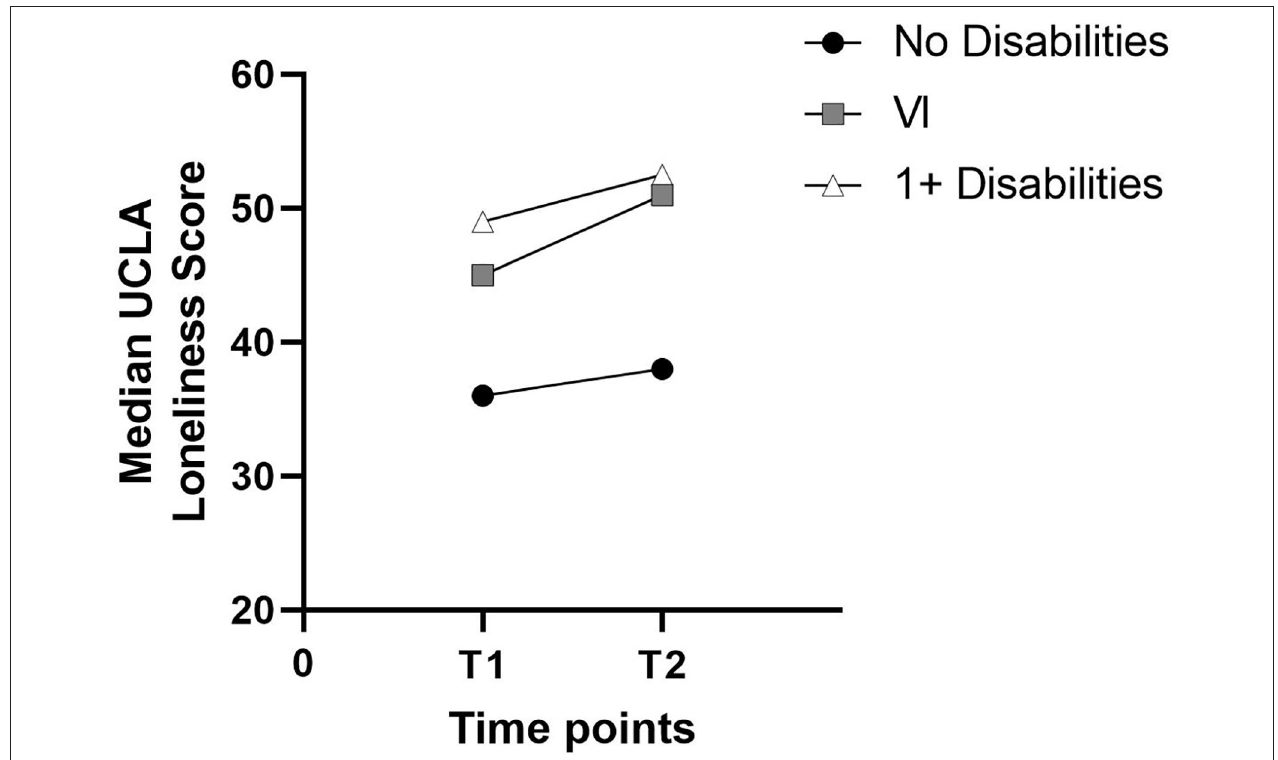
FIGURE 2 | Change in median UCLA loneliness between T1 and T2 by subgroup.